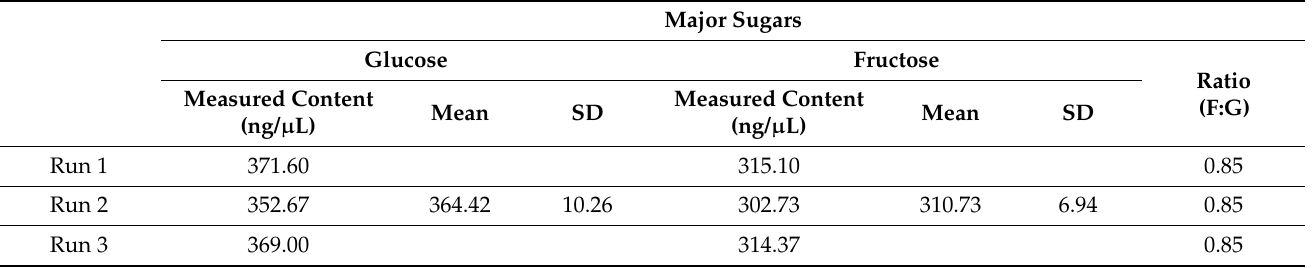
Table 1 . Glucose and fructose content and fructose-to-glucose ratio (F: G) of honey . Table 1. Glucose and fructose content and fructose-to-glucose ratio (F: G) of